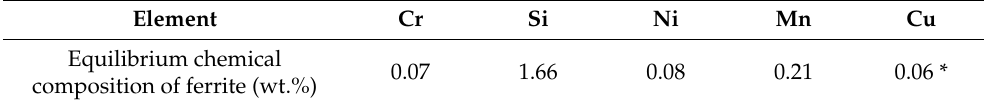
Table 4. Equilibrium chemical composition of ferrite at 500 ◦ C according to JMatPro 13 software. Element Cr Si Ni Mn Cu Equilibrium chemical 0.07 1.66 0.08 0.21 0.06 composition of ferrite (wt.%)